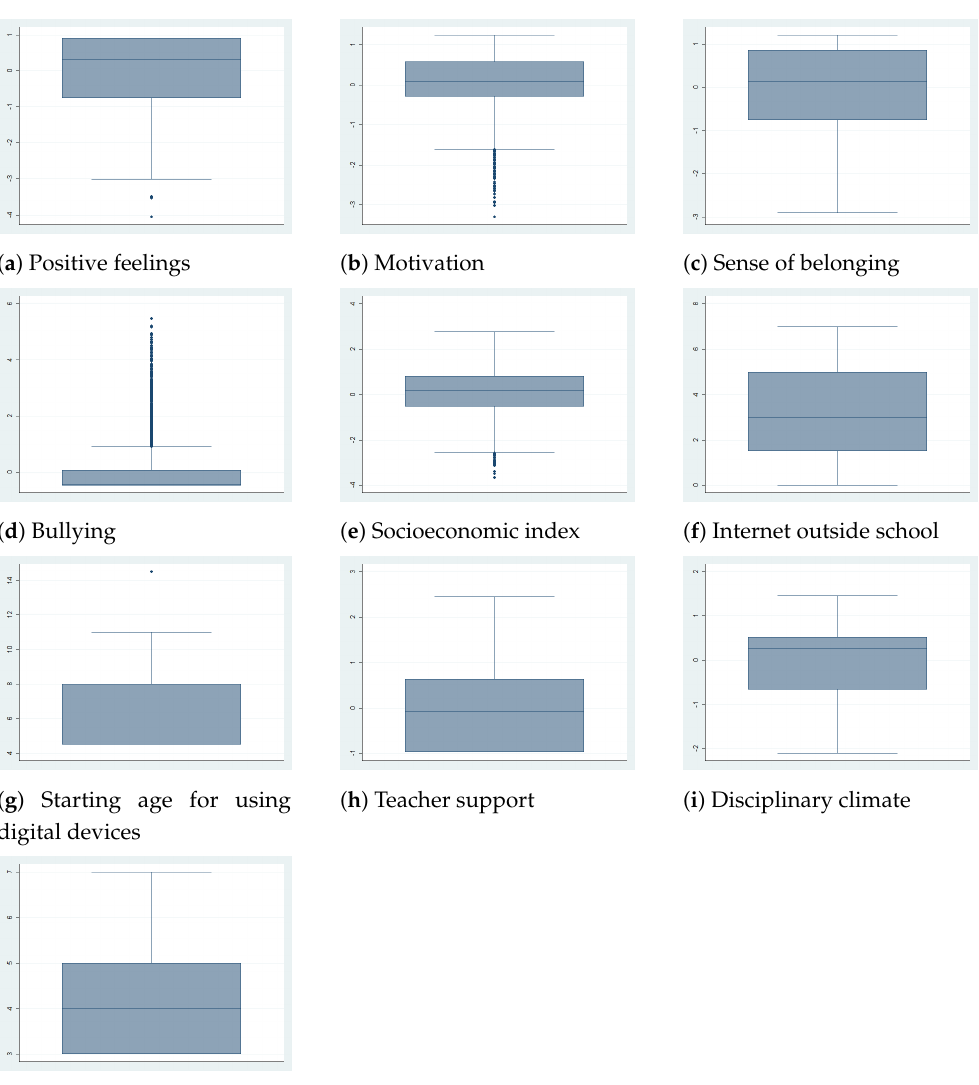
Figure 1. Box-plots of the variables for the Spanish sample. According to the observational data, in Spain, 29.5% of the students are enrolled in semi-private schools, whereas 70.5% of them are enrolled in public schools. In the case of Finland, the semi-private school students only represent 3.6% of the sample, while 96.4% of the pupils attend a public school, which implies that there are hardly any semi-private schools in Finland.